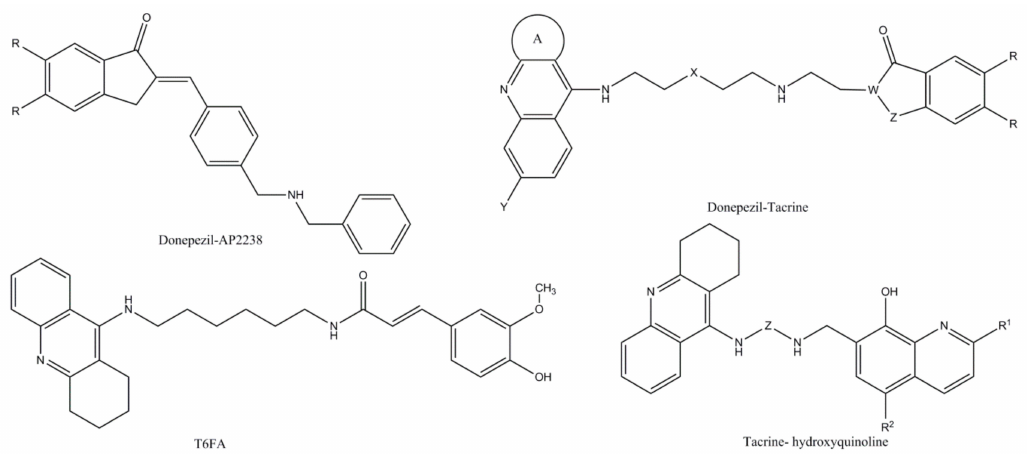
Figure 6. Hybrid ChEIs. The molecular structures of donepezil–tacrine hybrid, tacrine–ferulic acid (T6FA) hybrid, and tacrine and 8-hydroxyquinoline hybrids.